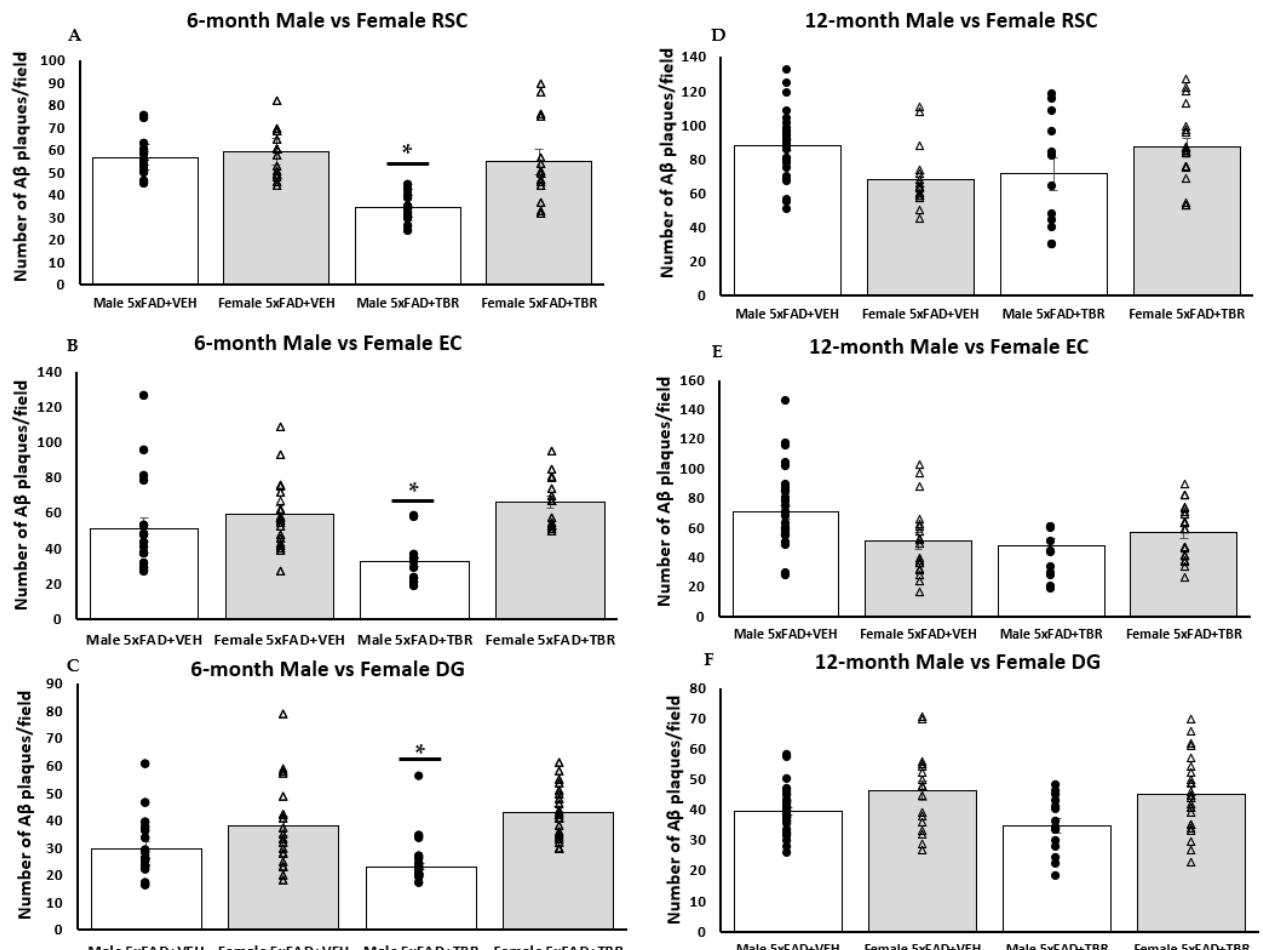
Figure 10. ( A – C ). Effect of TBR on Aβ plaque deposits in 5xFAD mice. ( A ) Representative image from three locations: the dentate gyrus (DG), retrosplenial cortex (RSC), and the entorhinal cortex (EC) for 6- and 12-month-old animals. ( B ) Using a two-tailed t -test, there was a significant differ- ence in total amyloid β deposits in the retrospleni al cortex between 5xFAD 6-month-old mice treated with TBR and 5xFAD mice treated with vehicle. ( C ) Using a one-tailed t -test, there was a significant difference in total amyloid β deposits between 5xFAD 12 -month-old mice treated with TBR and 5xFAD mice treated with vehicle. * p < 0.05.